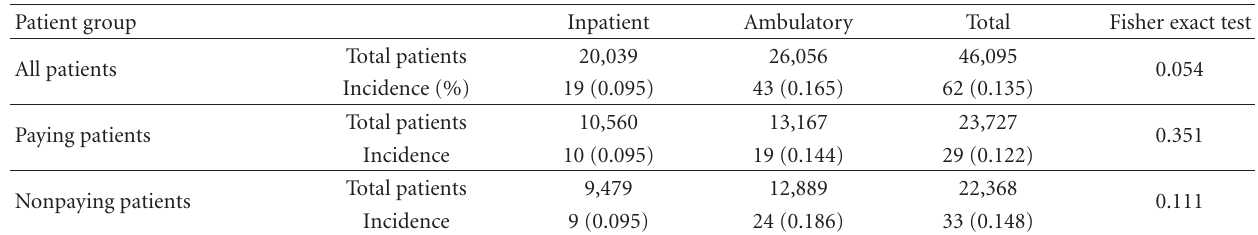
Table 2: The incidence of endophthalmitis following cataract surgery.